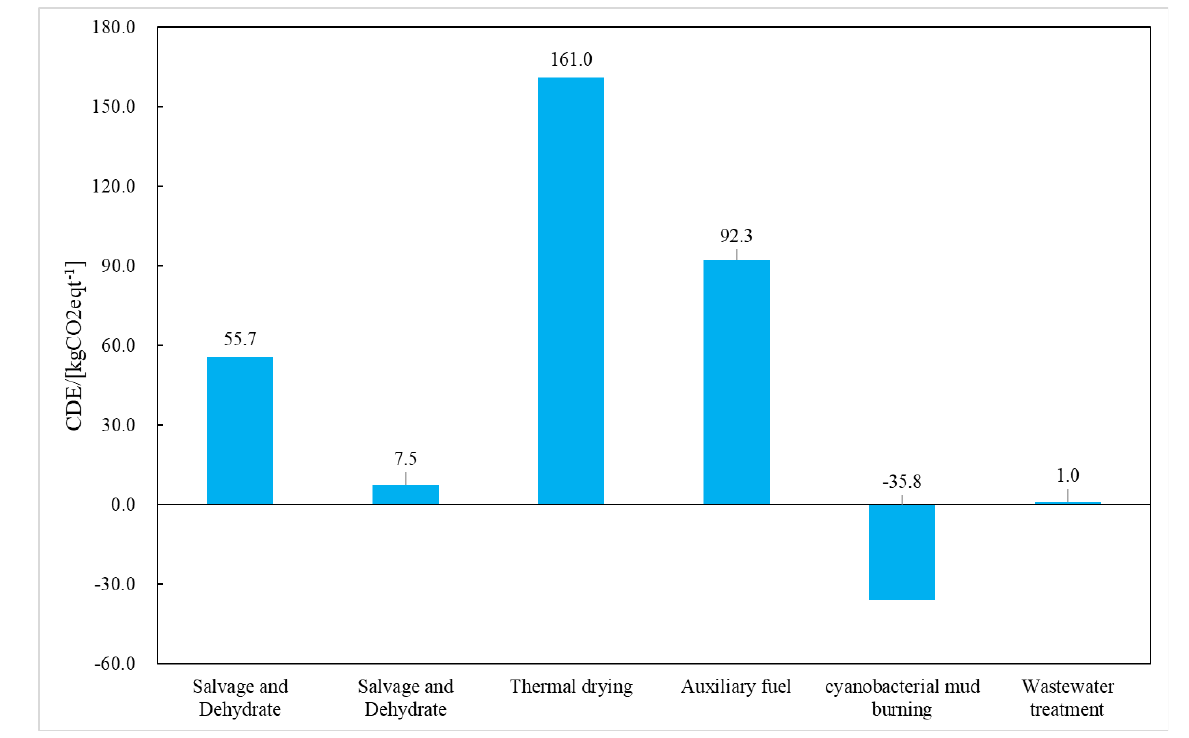
Figure 8. Carbon emission in each link of the cyanobacteria drying incineration process.